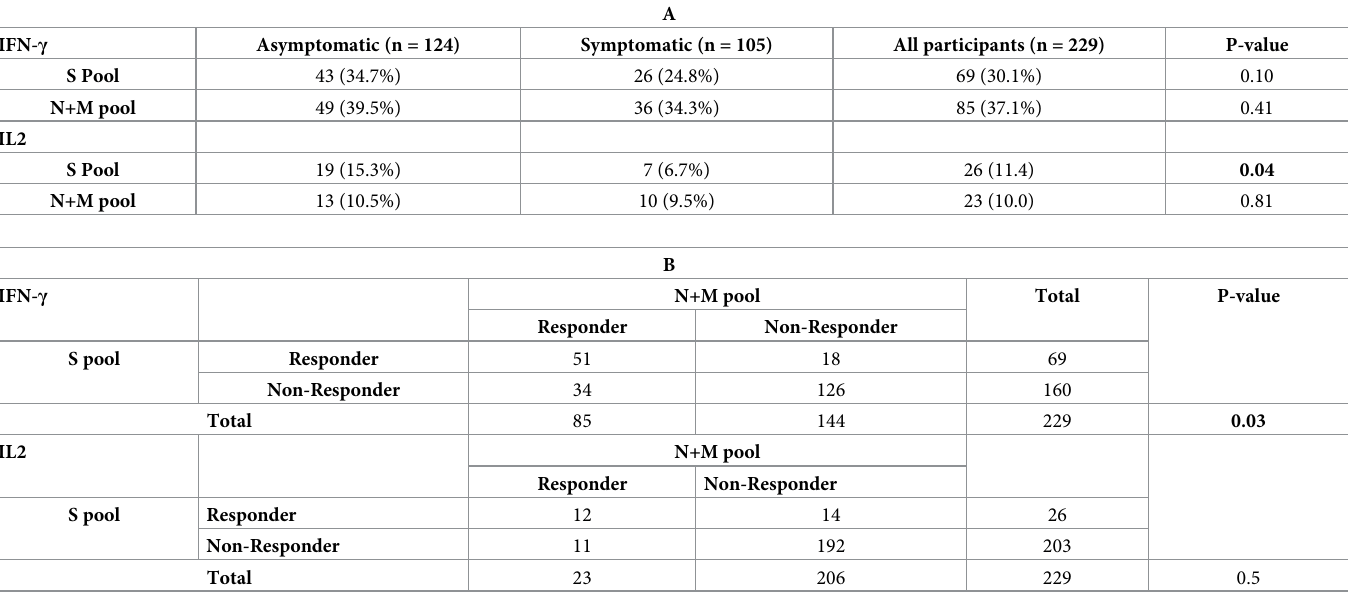
Table 1. Frequency of immune responses to the S and N+M peptide pools in asymptomatic and symptomatic participants.